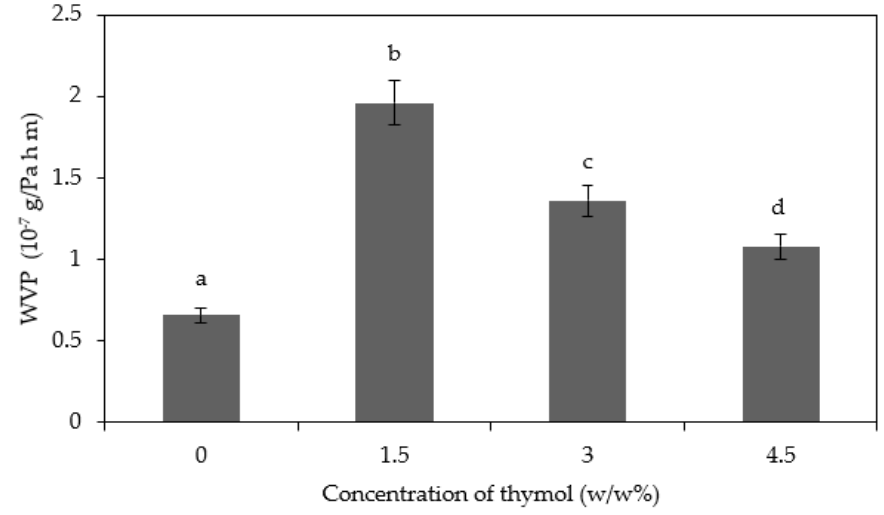
Figure 5. Water vapor permeability (WVP) of the CS/CNP/Thy bio-nanocomposite films incorporated with different concentrations of thymol. Different letters in the same graph indicate a statistically significant difference ( p < 0.05).